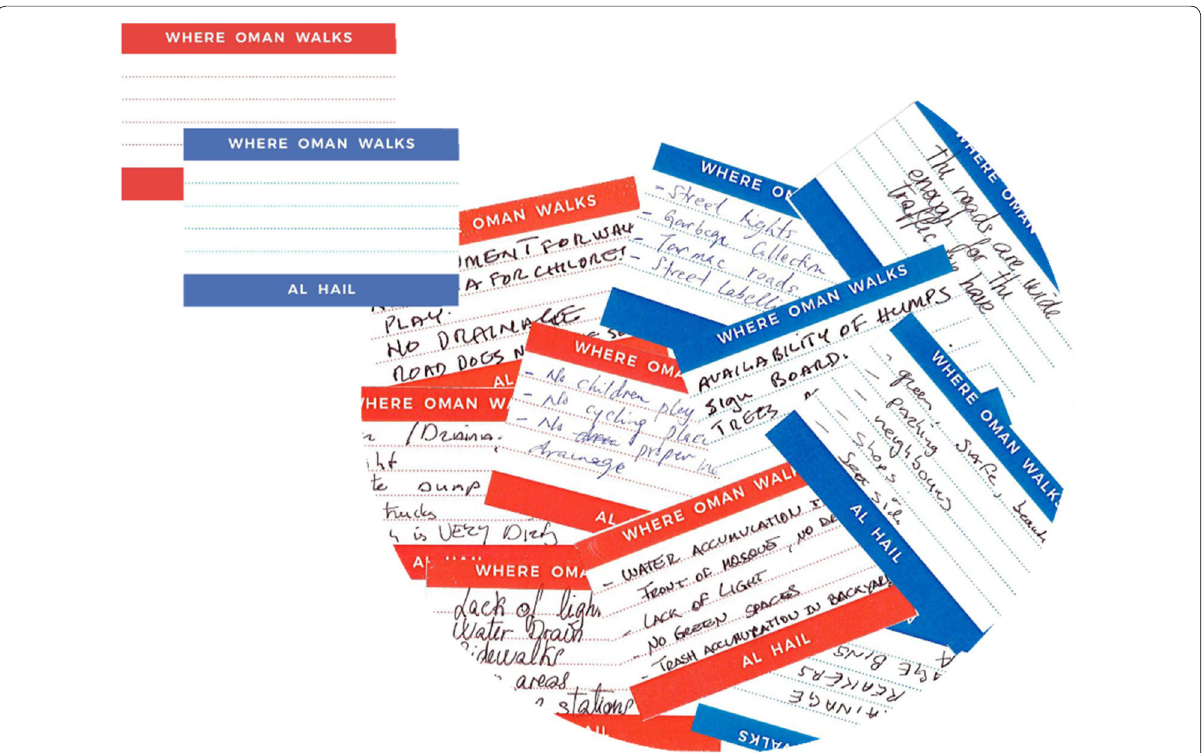
Fig. 8 The cue cards were carried out in a group analysis phase at the beginning of the workshop, yet there was no limit to the extension of leaves room for